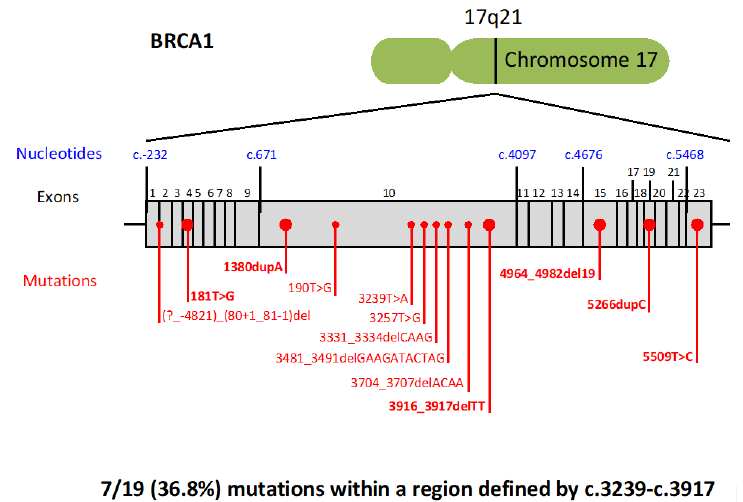
Figure 2. Distribution of BRCA1 pathogenic variants. The mutations detected twice are shown in bold. Cancers 2019 , 11 , 193